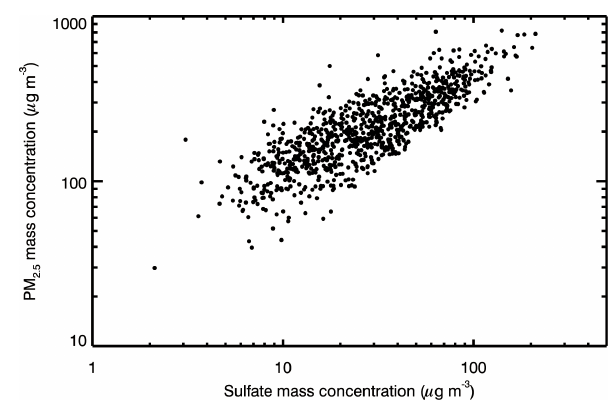
Figure 2. Scatter plot of the observed sulfate with PM 2 . 5 mass con- centrations at the IEECAS site in Xi’an during the wintertime from 2003 to 2011.